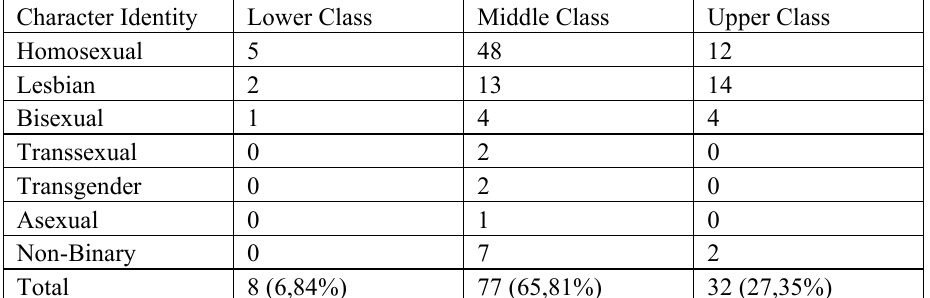
Table 11. LGBT+ character socio-cultural class in Flemish television fiction (2001 – 2016)